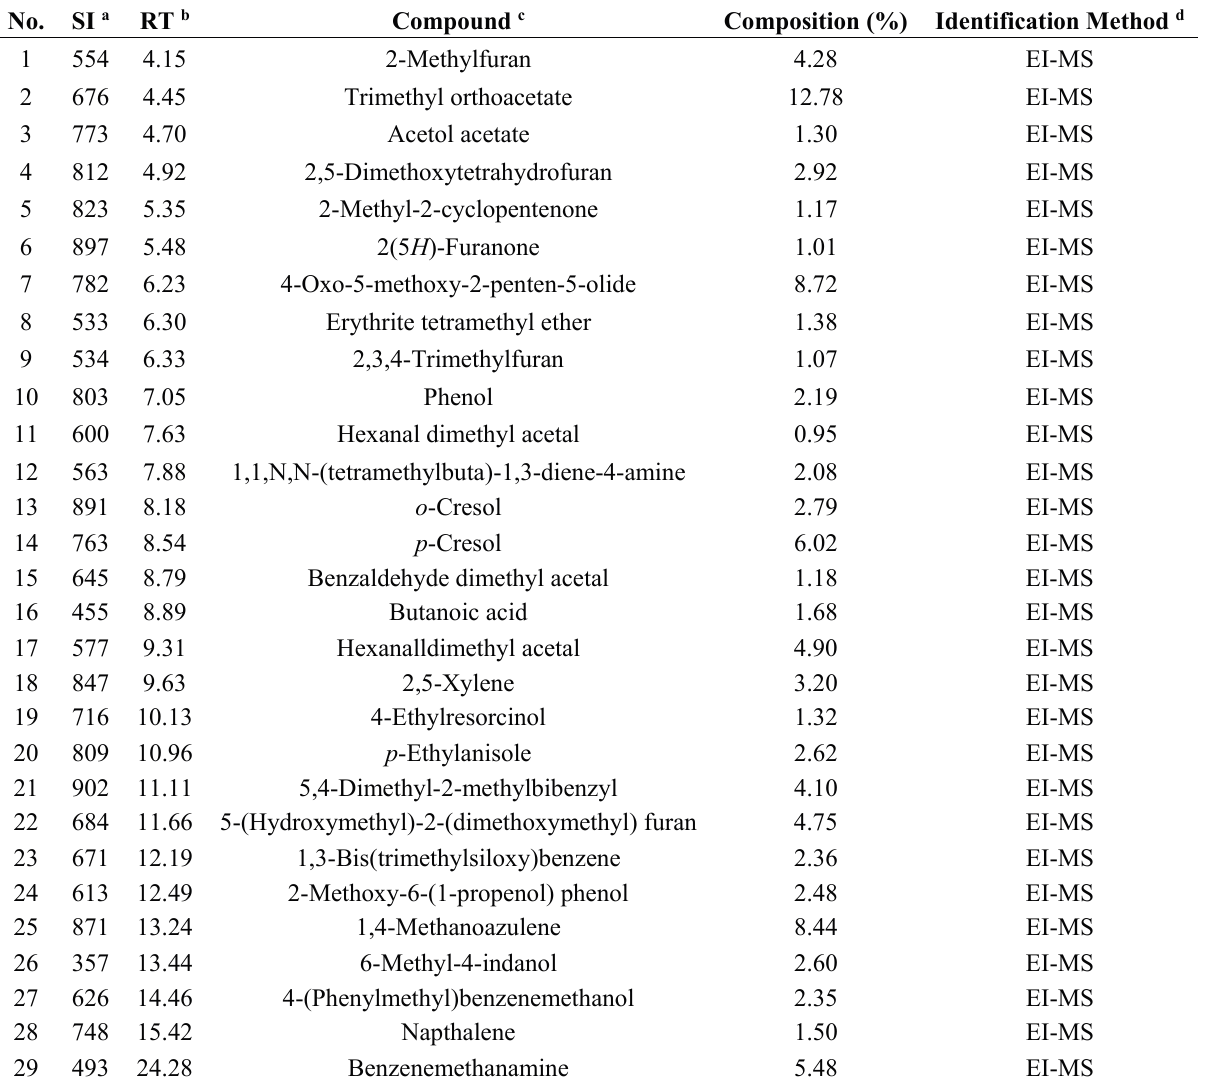
Table 2. Major components of Japanese red pine sawdust bio-oil (SBO) based on GC-MS analysis.